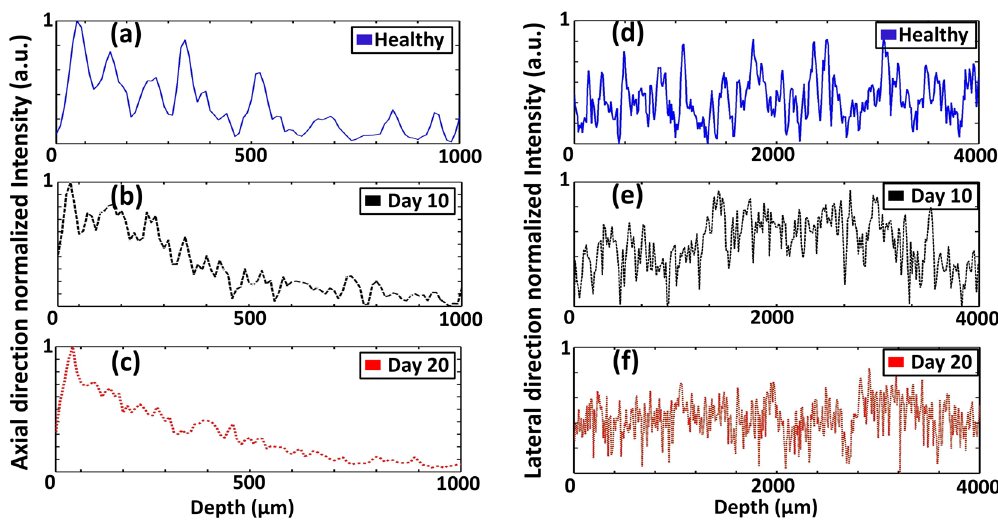
Figure 8. Normalized axial direction A-scan depth profiles and lateral direction intensity profiles evaluated from healthy specimens, and infected specimens respectively acquired at 10 and 20 days after the specimen